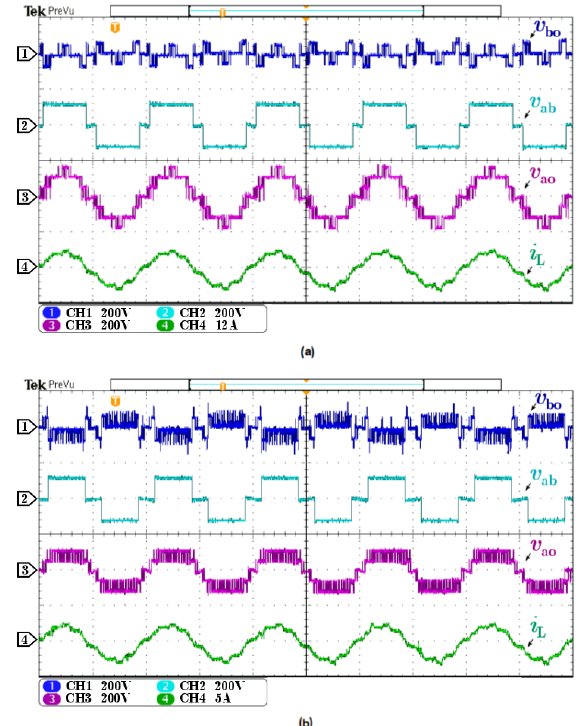
Figure 12. Experimental waveform of respective converter modules and inverter current at load-B, ( a ) when M = 1.1, traces channel 1, 2, 3 (200 V/div) and 4 (5 A/div), ( b ) when M = 0.9, traces channel 1, 2, 3 (200 V/div) and 4 (5 A/div).